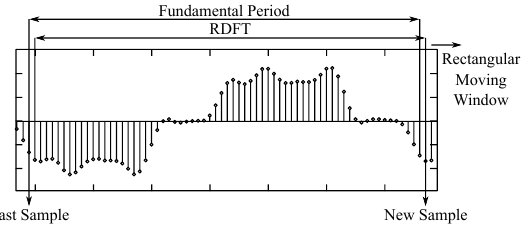
Figure 10. Recursive DFT